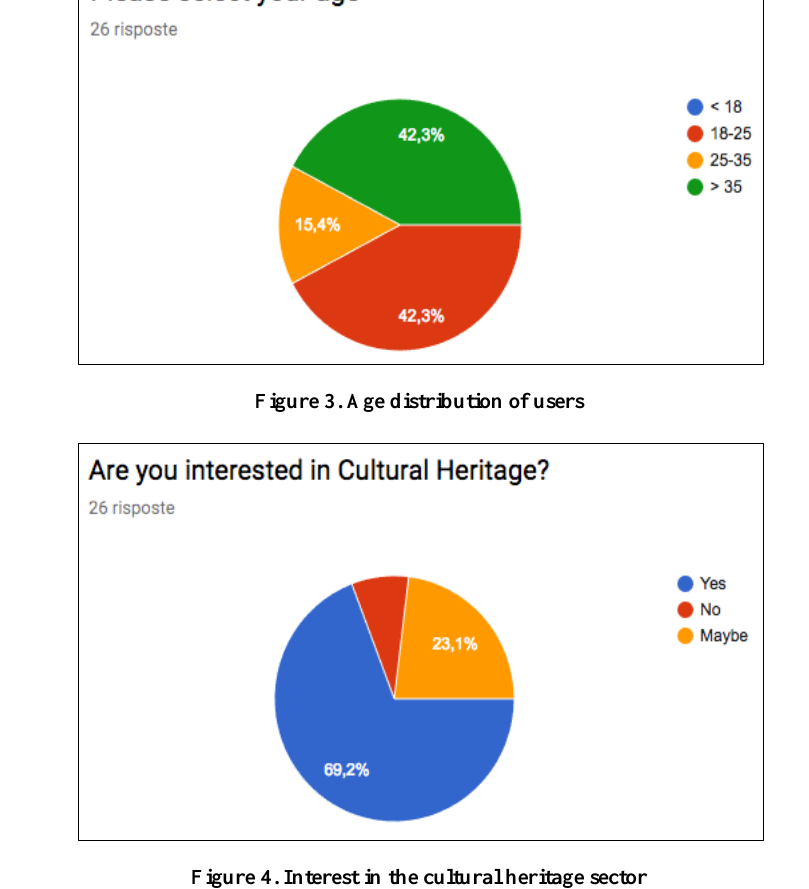
Figure 4. Interest in the cultural heritage sector